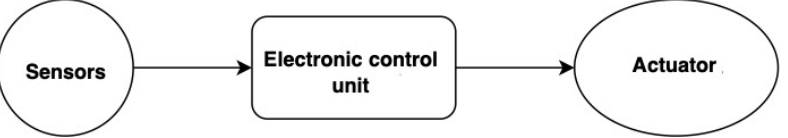
Figure 12. Automobile electronic